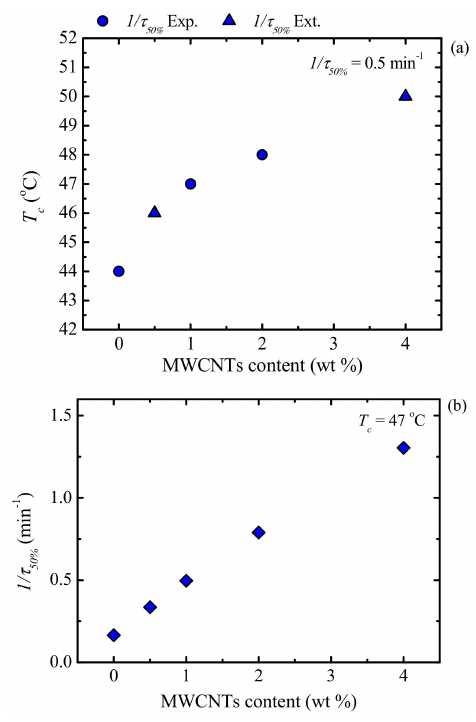
Figure 18. ( a ) Crystallization temperature as a function of MWCNT content at constant 1/ τ 50% = 0.5 min − 1 ; ( b ) overall crystallization rate as a function of MWCNT content at constant T c = 47 ◦